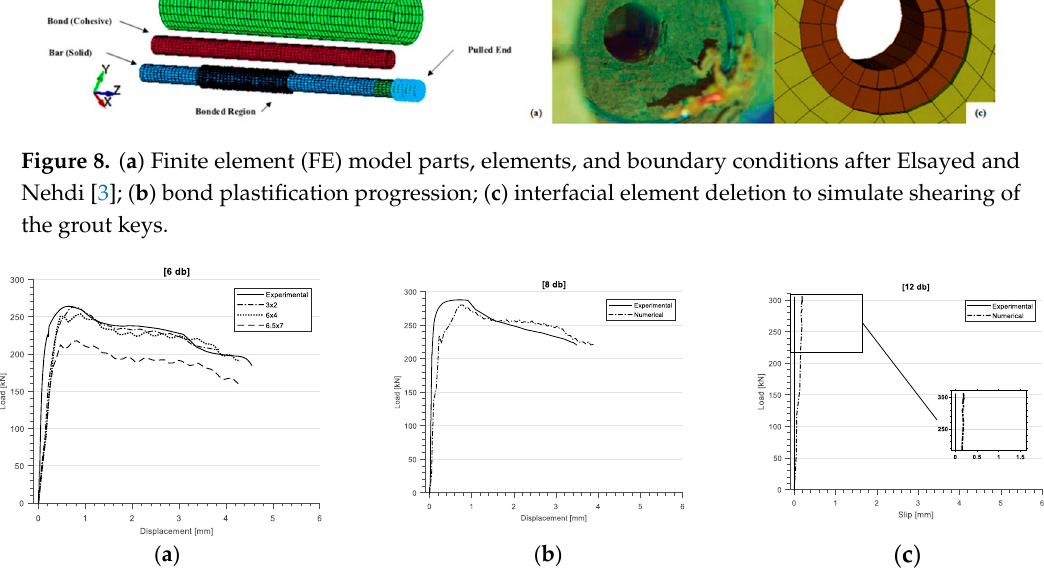
Figure 9. ( a ) FE analysis of bond slip tests by Elsayed and Nehdi [3]: ( b,c ) load vs. free-end slip response at 6, 8, and 12 d b (1 × 2 mm mesh not shown for clarity).